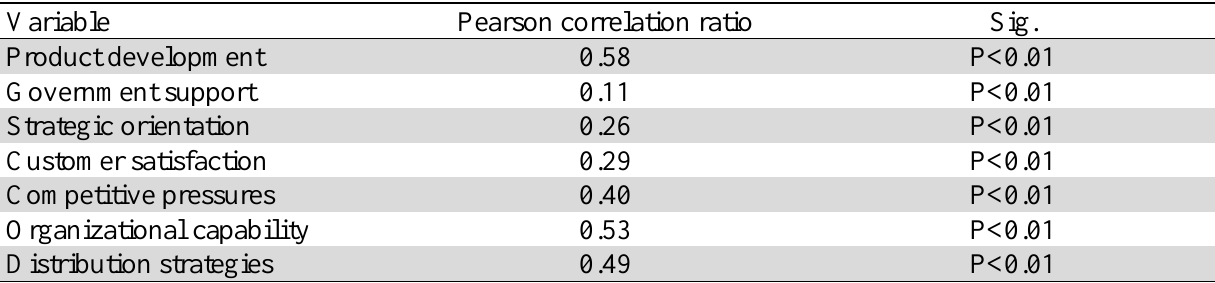
The summary of factors Pearson correlation test between supply chain management and export development